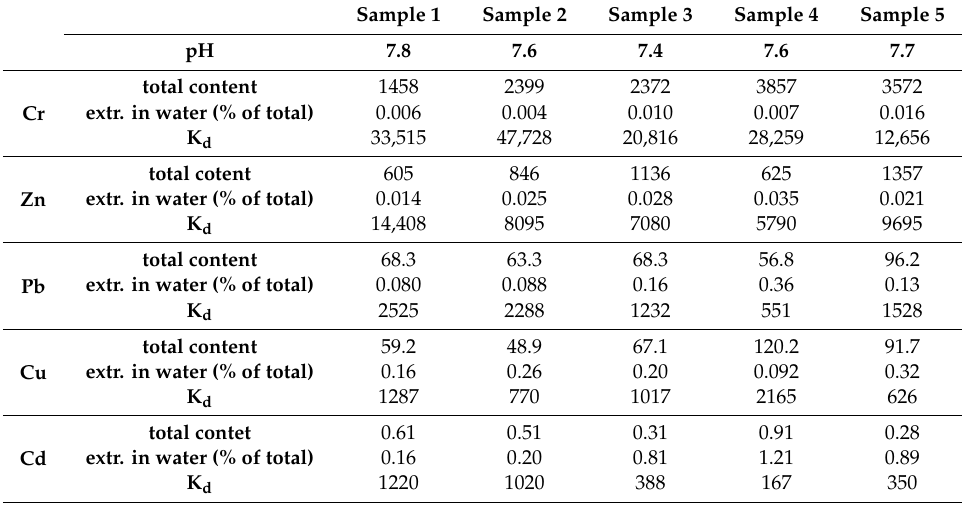
Figure 4. Comparison of the Cr, Zn Pb, Cu, and Cd amounts extracted by NH 4 NO 3 (small graphs within the main graphs), EDTA, and Step 1 of the BCR sequential extraction. For Pb, the NH 4 NO 3 extracted amounts were for all samples < 0.1 mg/kg. Table 5. Amounts of the Cr, Zn, Pb, Cu, and Cd extracted by water as % of the total content (aqua regia digestion), and the calculated K d value for five random samples. K d = C soil / C water